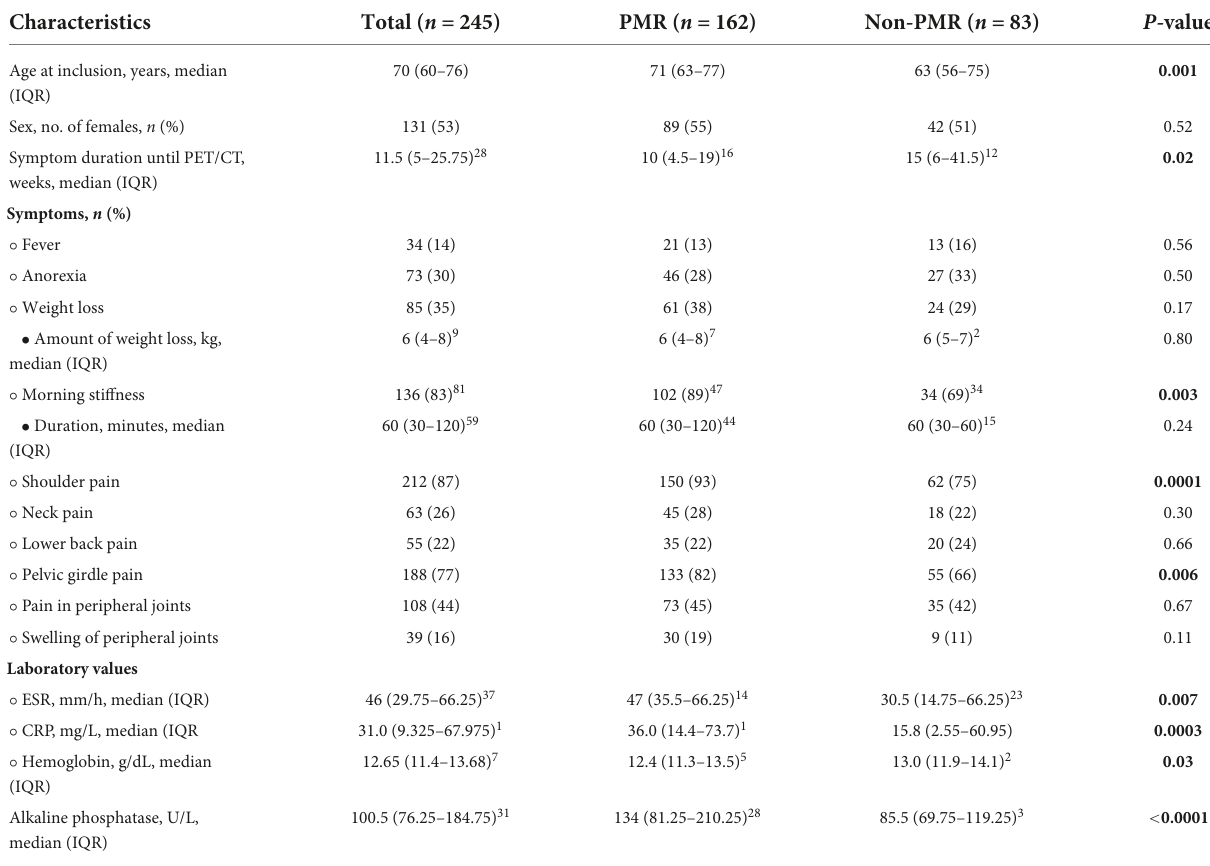
TABLE 1 Baseline characteristics for the entire